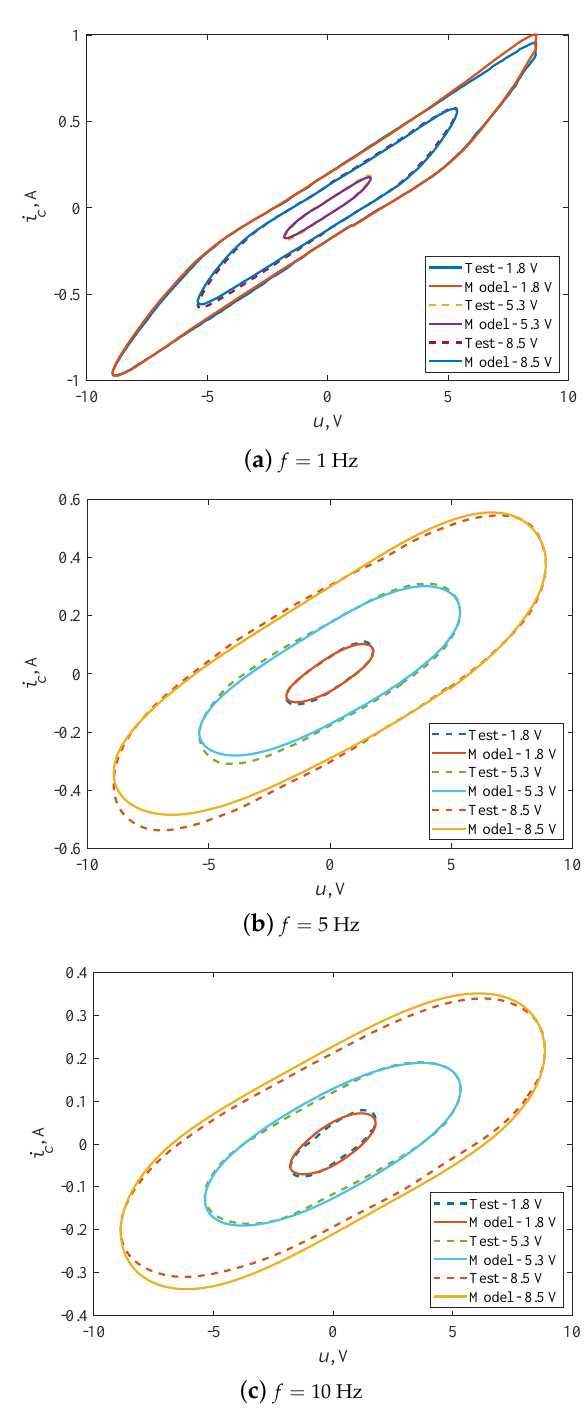
Figure 7. Coil current vs. voltage i c − u (one cycle): model vs.